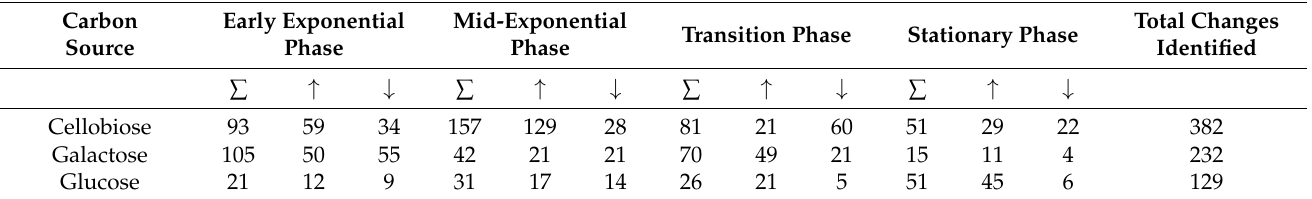
Table 1. Numbers of all genes whose expression profile was altered by the presence of pIL1-7 plasmids from L. lactis IL594 during growth on different sugars and at different growth phases. ↑ , number of up-regulated genes; ↓ , number of down-regulated genes; ∑ , sum of up- and down-regulated genes per growth